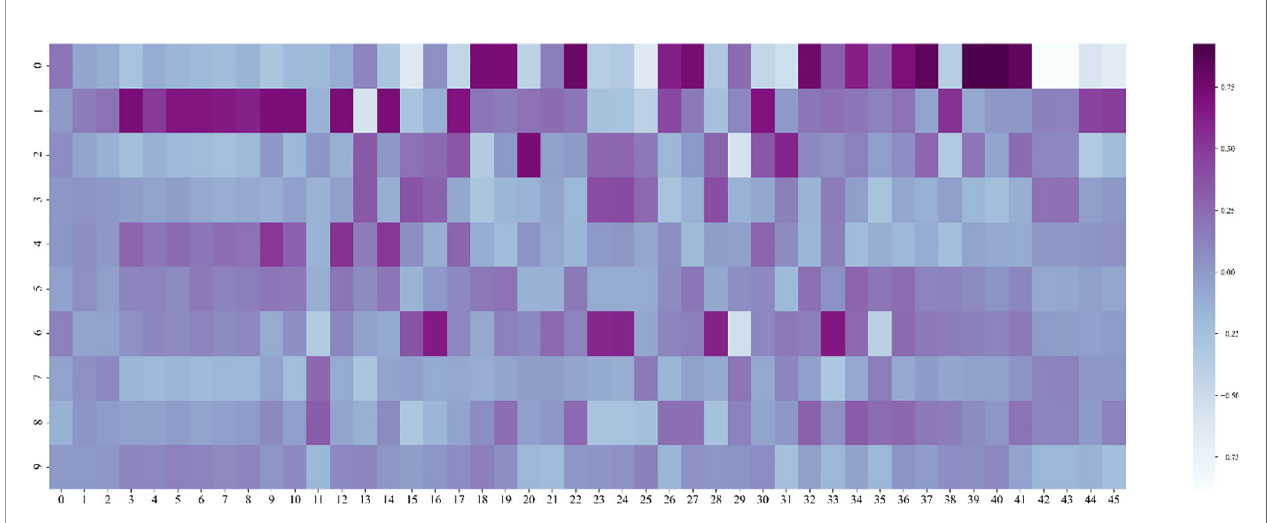
FIGURE 9 | Heat map of feature dimensionality